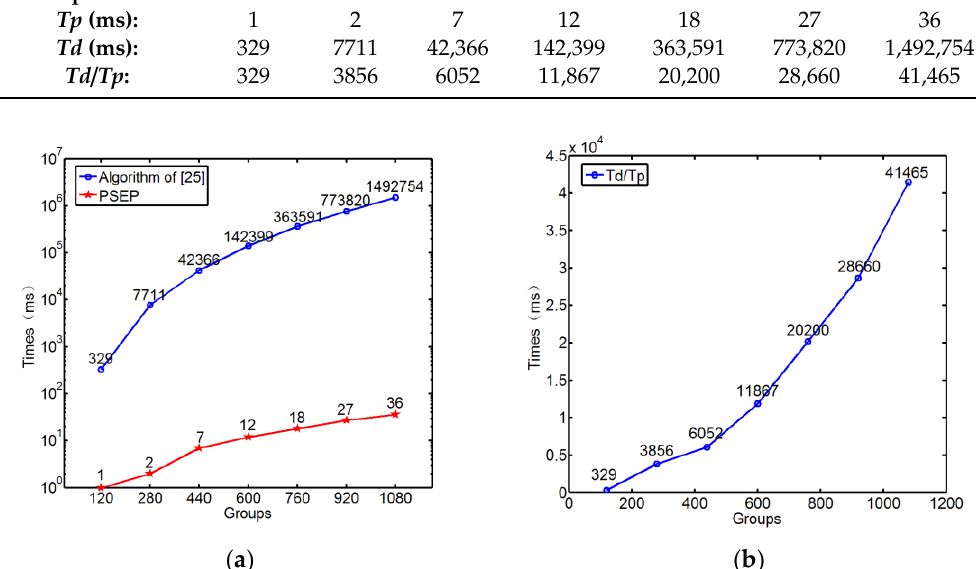
Figure 11. Comparison of the efficiency of the two algorithms. ( a ) The curves of the consumed